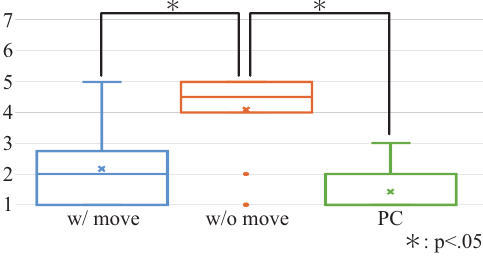
Figure 13. Results (“Did you feel motion